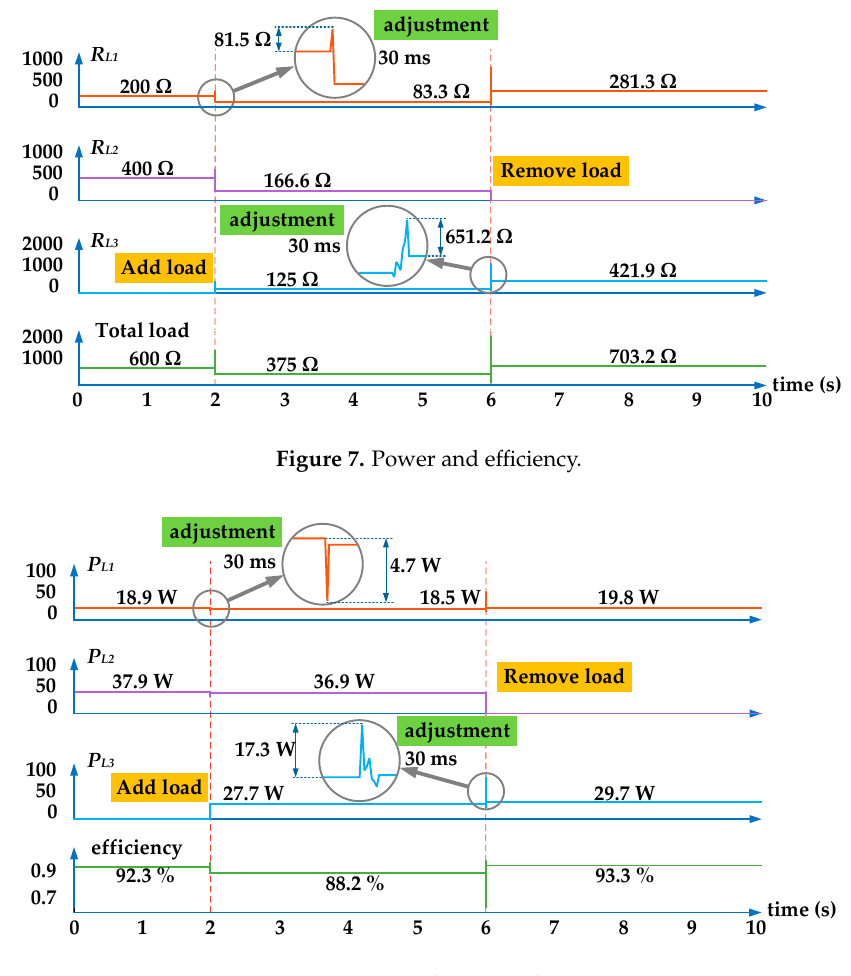
Figure 8. Equivalent impedance.